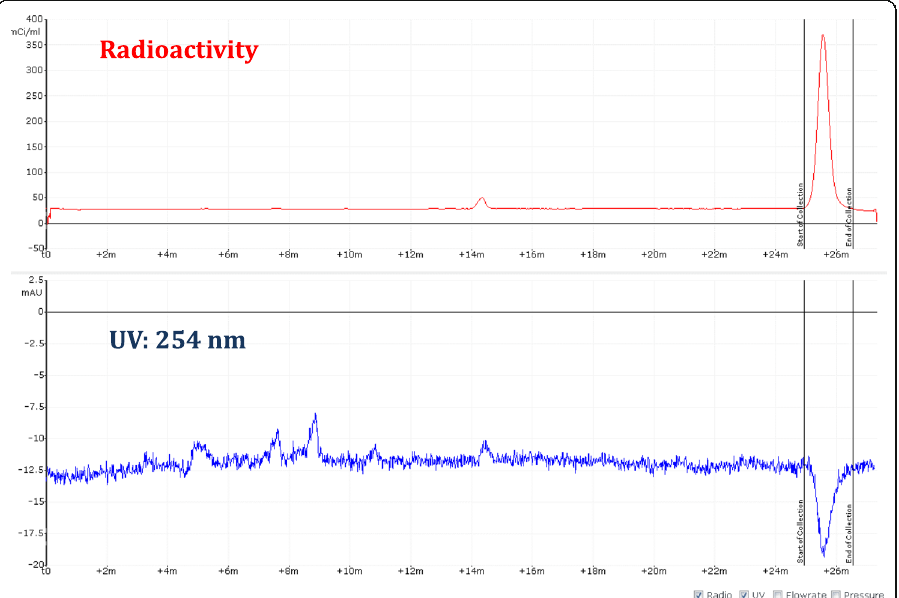
Fig. 12 A view of typical semi-preparative chromatogram of [ 18 F]F-Gln